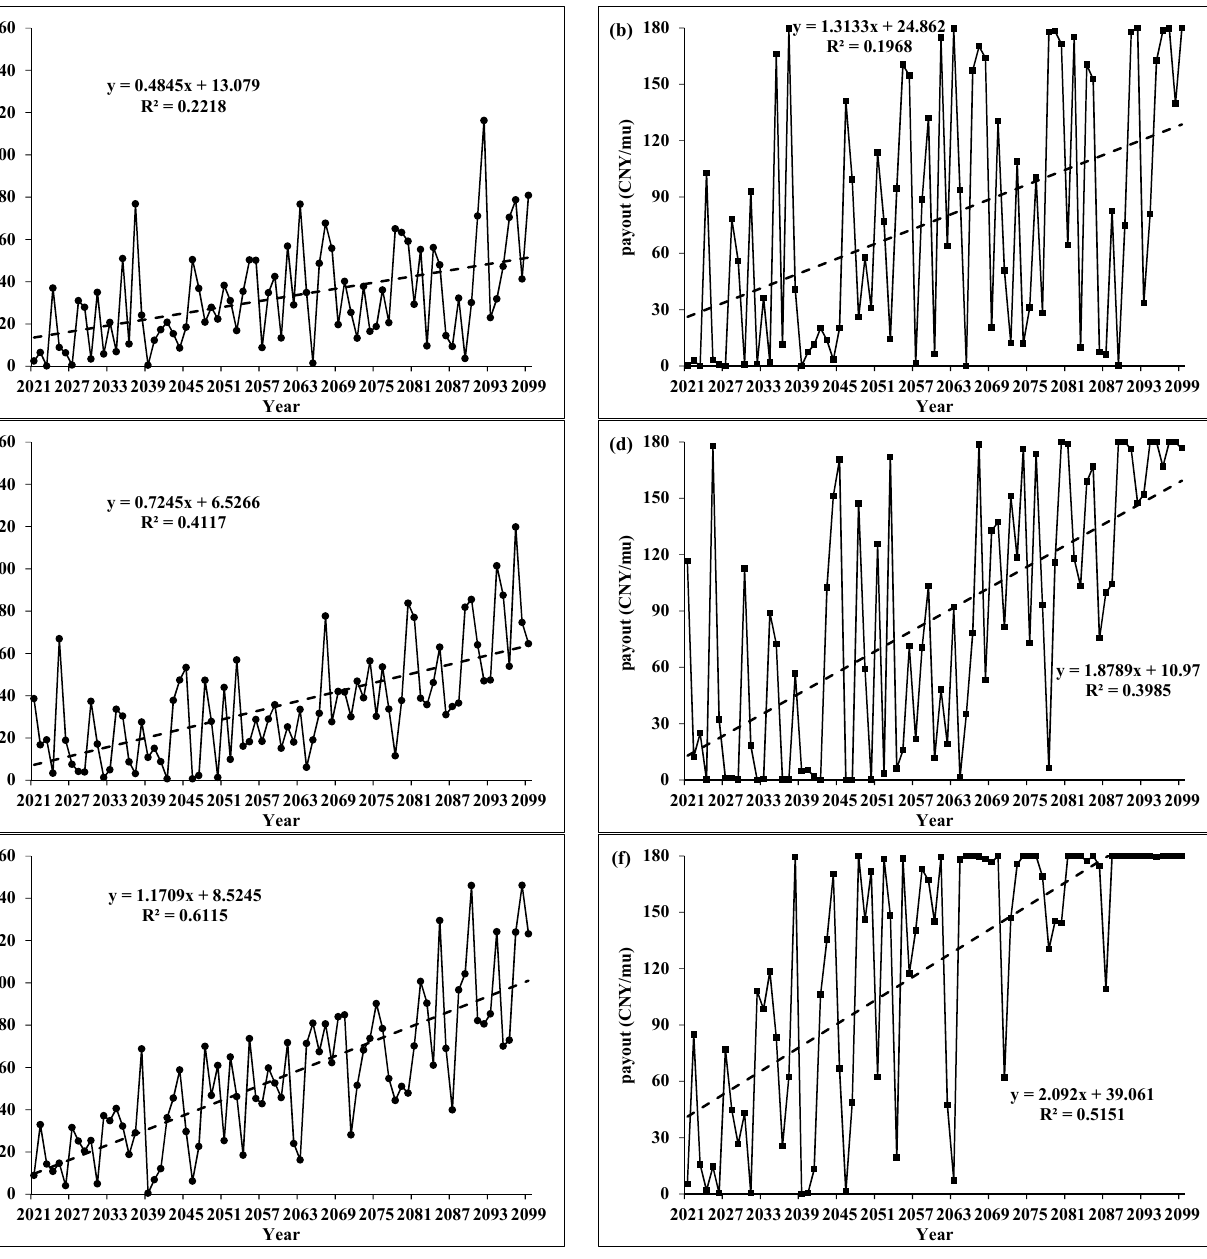
Figure 6. Annual variation in HSWI and payout due to rice heat stress in the area south of the Huai River in Anhui Province from 2021 to 2099 under RCP4.5 ( a , b ), RCP6.0 ( c , d ) and RCP8.5 ( e , f ). The projected HSWI under the three RCPs ranged between 18.4 and 23.1 °C, 27.4 and